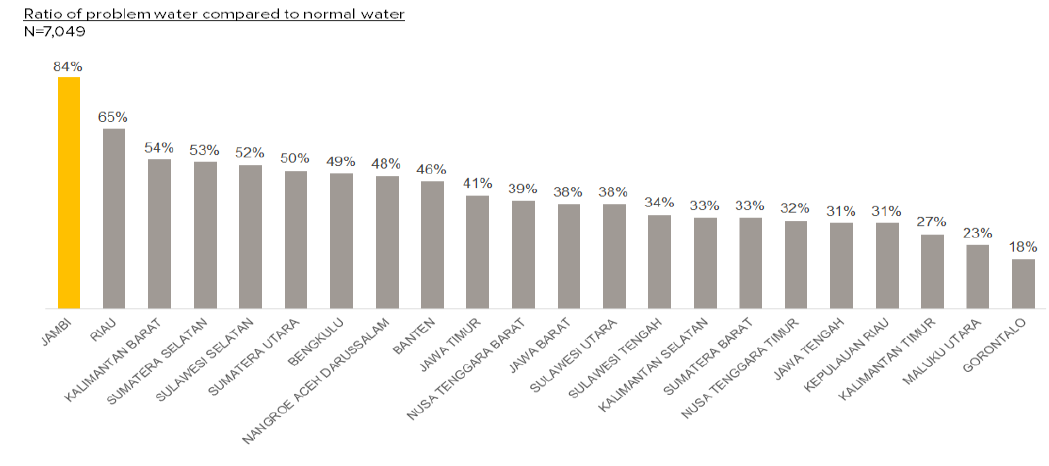
Figure 2: The Water Problem compared to Normal Water; Sources: Pulse Lab Jakarta,